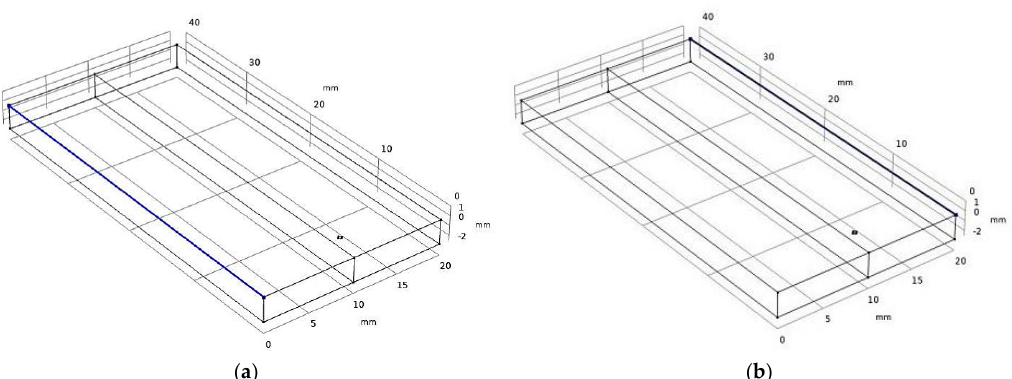
Figure 14. Edge temperature probes ( a ) x = 0, ( b ) x = 20, and on the z = 0 surface.